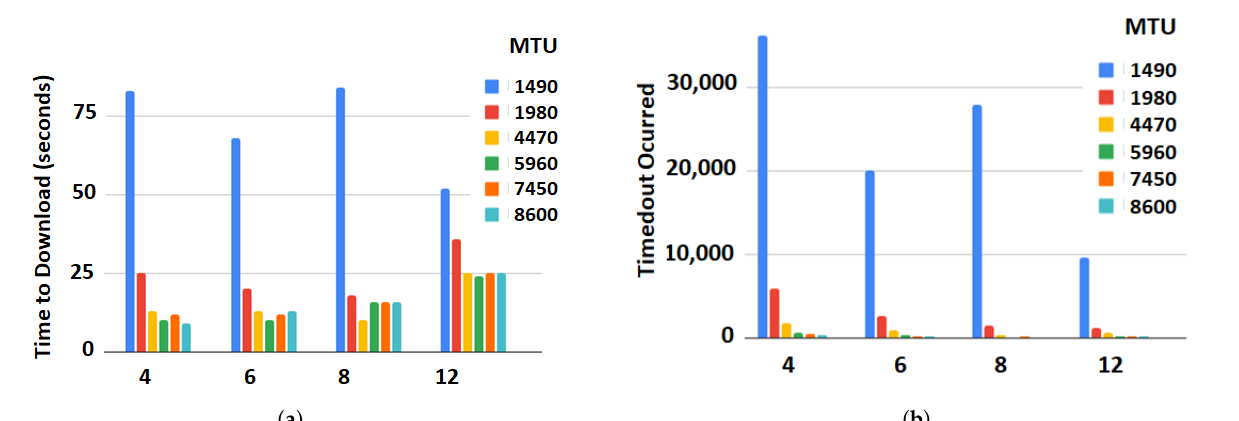
Figure 11. Download durations and number of timeout events for different MTUs and Interest timeouts. ( a ) Time to download file. ( b )